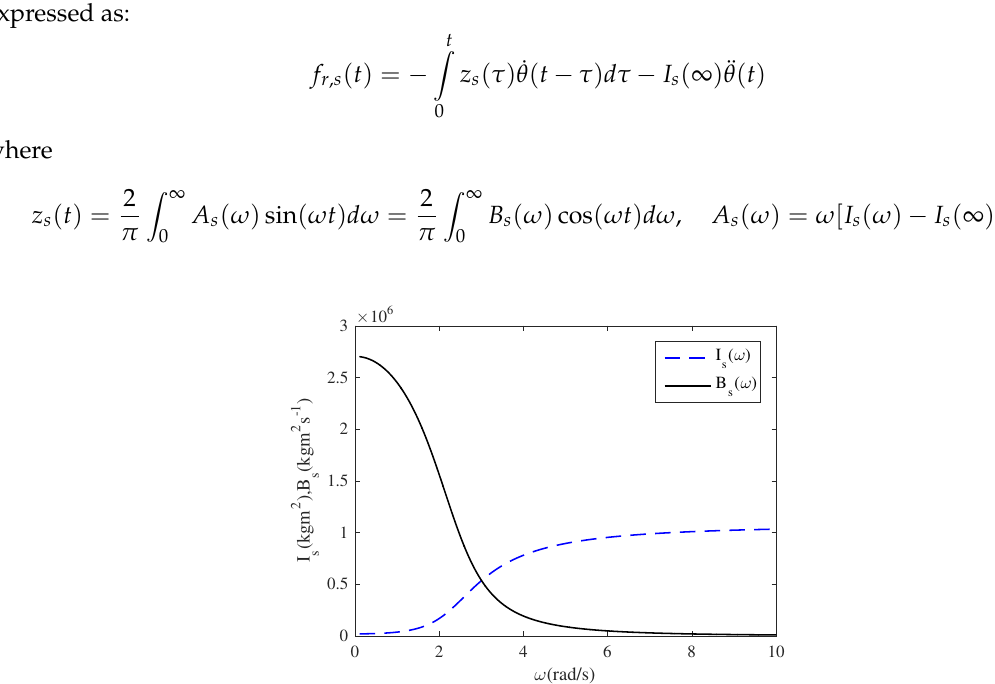
Figure 3. Variation of added inertia (dotted line) and the radiation damping (solid line) with frequency ( ω )